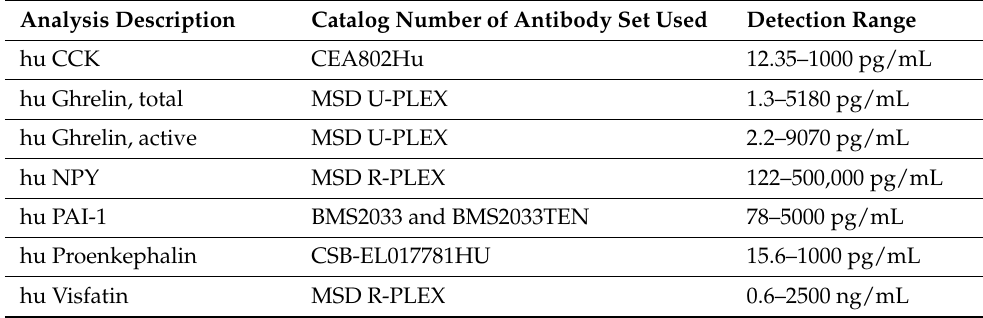
Table 2. Description of